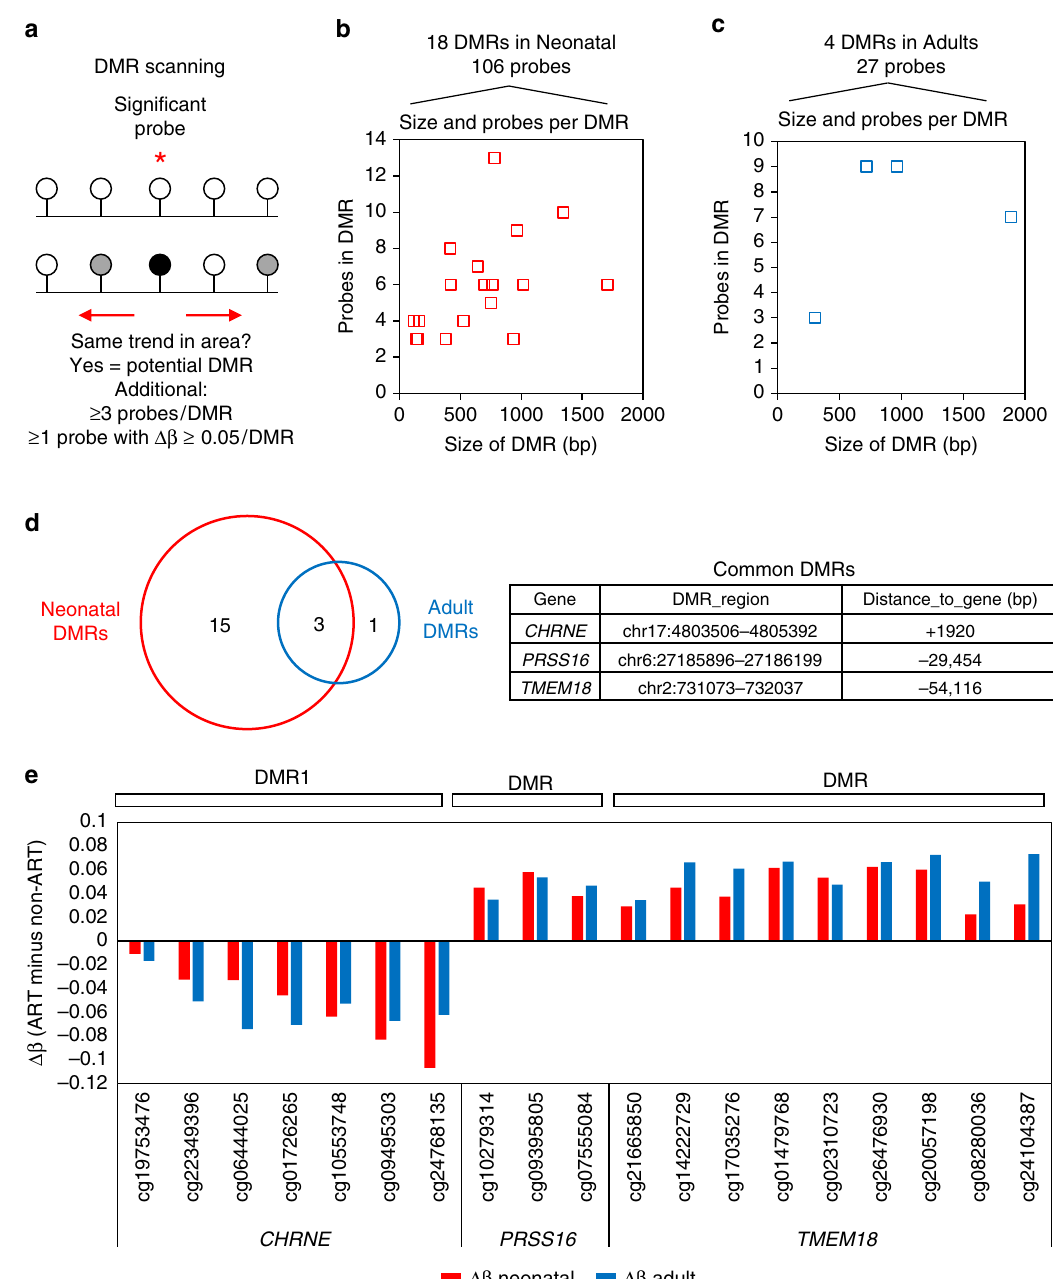
Fig. 2 Identi fi cation of ART-associated differentially methylated regions in neonatal and adult blood. a . Overview of the strategy used to identify DMRs. For each probe with an adjusted p -value <0.05 (Bayesian levene ’ s test) identi fi ed during linear regression analysis, DMRcate was used to scan the surrounding region for probes that show the same general DNA methylation change. Once regions were identi fi ed by DMRcate, the following cut-offs were used: at least 3 probes in the region, at least 1 of which has a Δβ ≥ 5%. b . Scatterplot of DMR size and number of probes within a DMR in neonatal blood. A total of 106 probes within 18 DMRs were identi fi ed, with the size ranging from 100 to 1700 bp and number of probes per DMR ranging from 3 to 13. c Scatterplot of DMR size and number of probes within a DMR in adult blood. A total of 27 probes within 4 DMRs were identi fi ed, with the size ranging from 300 to 1900 bp and number of probes per DMR ranging from 3 to 9. d Venn diagram showing that three DMRs which overlap between neonatal and adult blood. The name of nearest gene, location of DMR, and distance to gene TSS is shown for the common DMRs. e Column graph showing Δβ between mean ART and mean control for individual probes within the three common DMRs for neonatal (red) and adult (blue) blood. Probe ID and gene name are shown on the